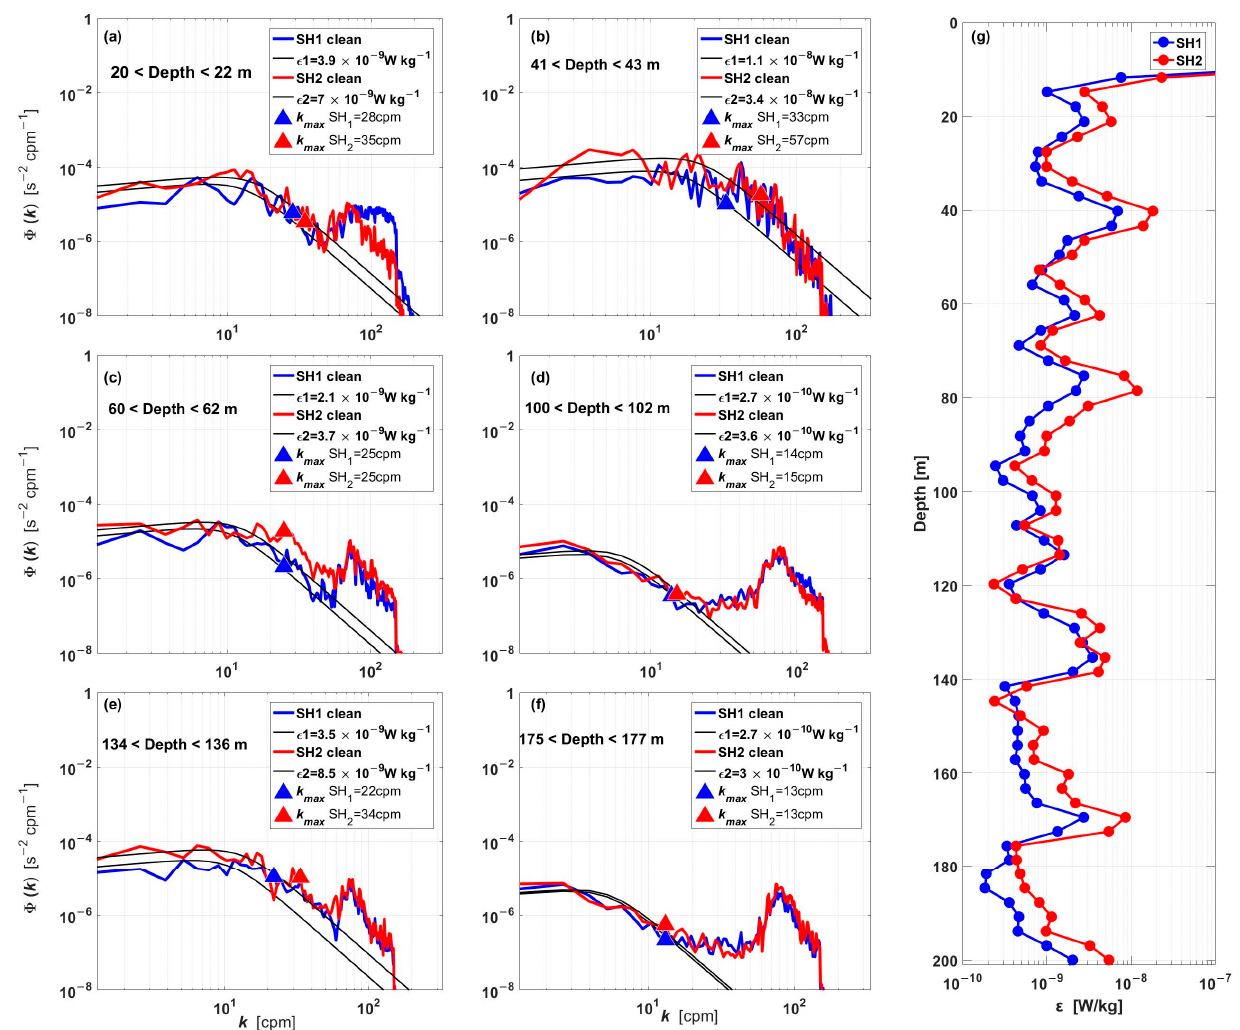
Figure 8. ( a – f ) Wavenumber shear spectrum samples from two shear probes (red and blue lines). The Nasmyth spectrum (black line) is shown for each case. Triangles (red and blue) mark the limits of k max . The corresponding ε and depth are included in each plot. ( g ) The profile of ε calculated from the velocity shear.